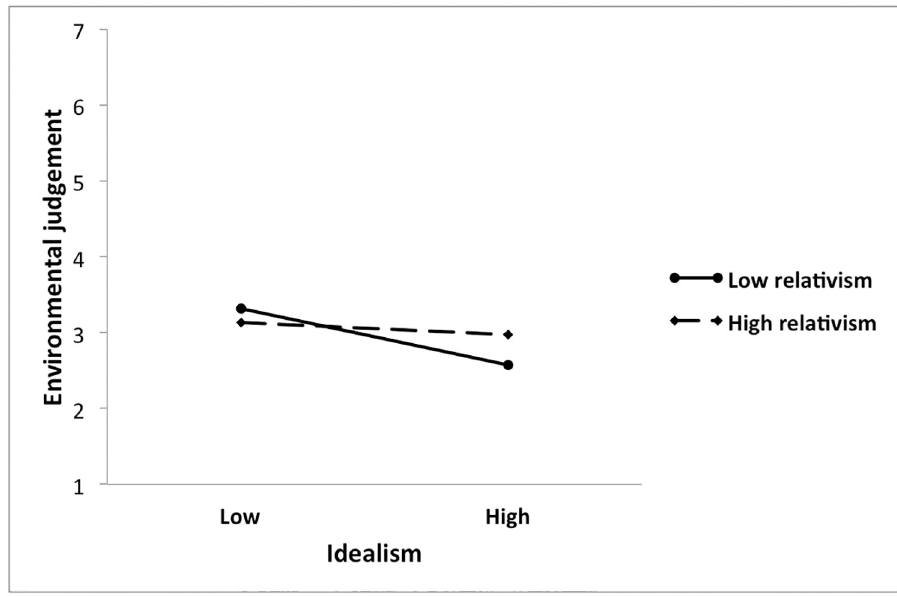
Fig 1. Interaction between idealism and relativism in predicting environmental